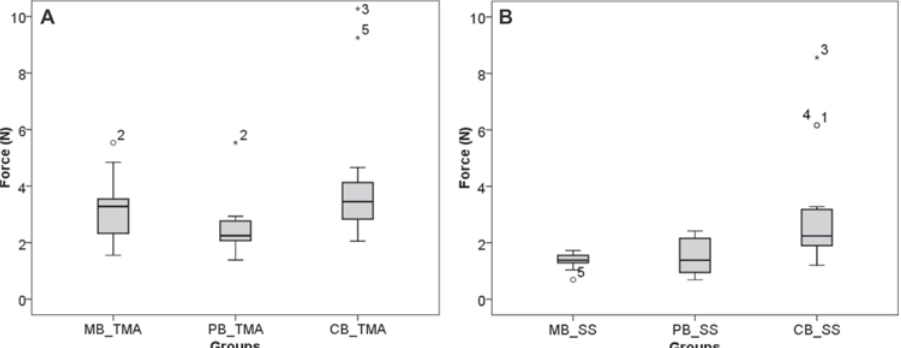
Figure 3- (cid:2)G(cid:11)H(cid:2)"(cid:9)(cid:11)(cid:4)(cid:2)(cid:7)(cid:17)(cid:11)(cid:22)(cid:6)(cid:12)(cid:28)(cid:2)(cid:19)(cid:5)H(cid:6)(cid:19)>(cid:19)(cid:2)(cid:13)(cid:14)(cid:6)(cid:8)(cid:4)(cid:6)(cid:11)(cid:12)(cid:5)(cid:9)(cid:2)(cid:8)(cid:11)(cid:15)(cid:13)(cid:16)(cid:8)(cid:6)(cid:15)(cid:12)(cid:4)(cid:7)(cid:2)(cid:20)(cid:15)(cid:4)(cid:22)(cid:15)(cid:15)(cid:12)(cid:2)(cid:19)(cid:15)(cid:4)(cid:5)(cid:9)K(cid:2)"(cid:11)(cid:9)(cid:18)(cid:8)(cid:5)(cid:14)(cid:20)(cid:11)(cid:12)(cid:5)(cid:4)(cid:15)K(cid:2)(cid:5)(cid:12)(cid:10)(cid:2)(cid:8)(cid:15)(cid:14)(cid:5)(cid:19)(cid:6)(cid:8)(cid:2)(cid:20)(cid:14)(cid:5)(cid:8)(cid:21)(cid:15)(cid:4)(cid:7)(cid:2)(cid:6)(cid:12)(cid:2)(cid:5)(cid:7)(cid:7)(cid:11)(cid:8)(cid:6)(cid:5)(cid:4)(cid:6)(cid:11)(cid:12)(cid:2) with different wires: A) Stainless steel wire; B) Titanium-molybdenum alloy (TMA) wire. Simple analysis of variance (ANOVA) and Tukey’s test as post hoc